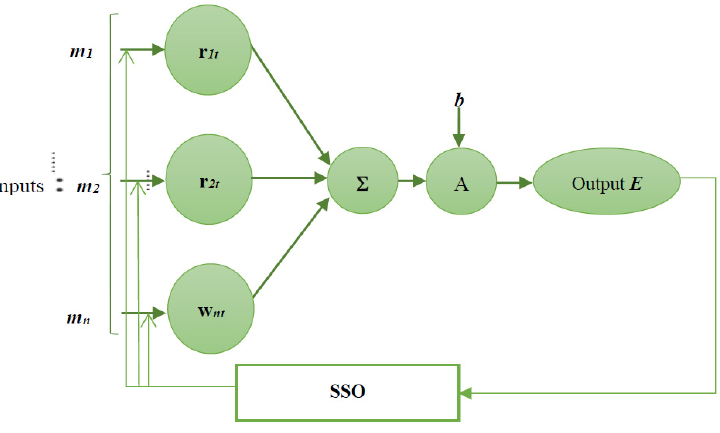
Figure 3. Structure of the proposed SSO-ANN.